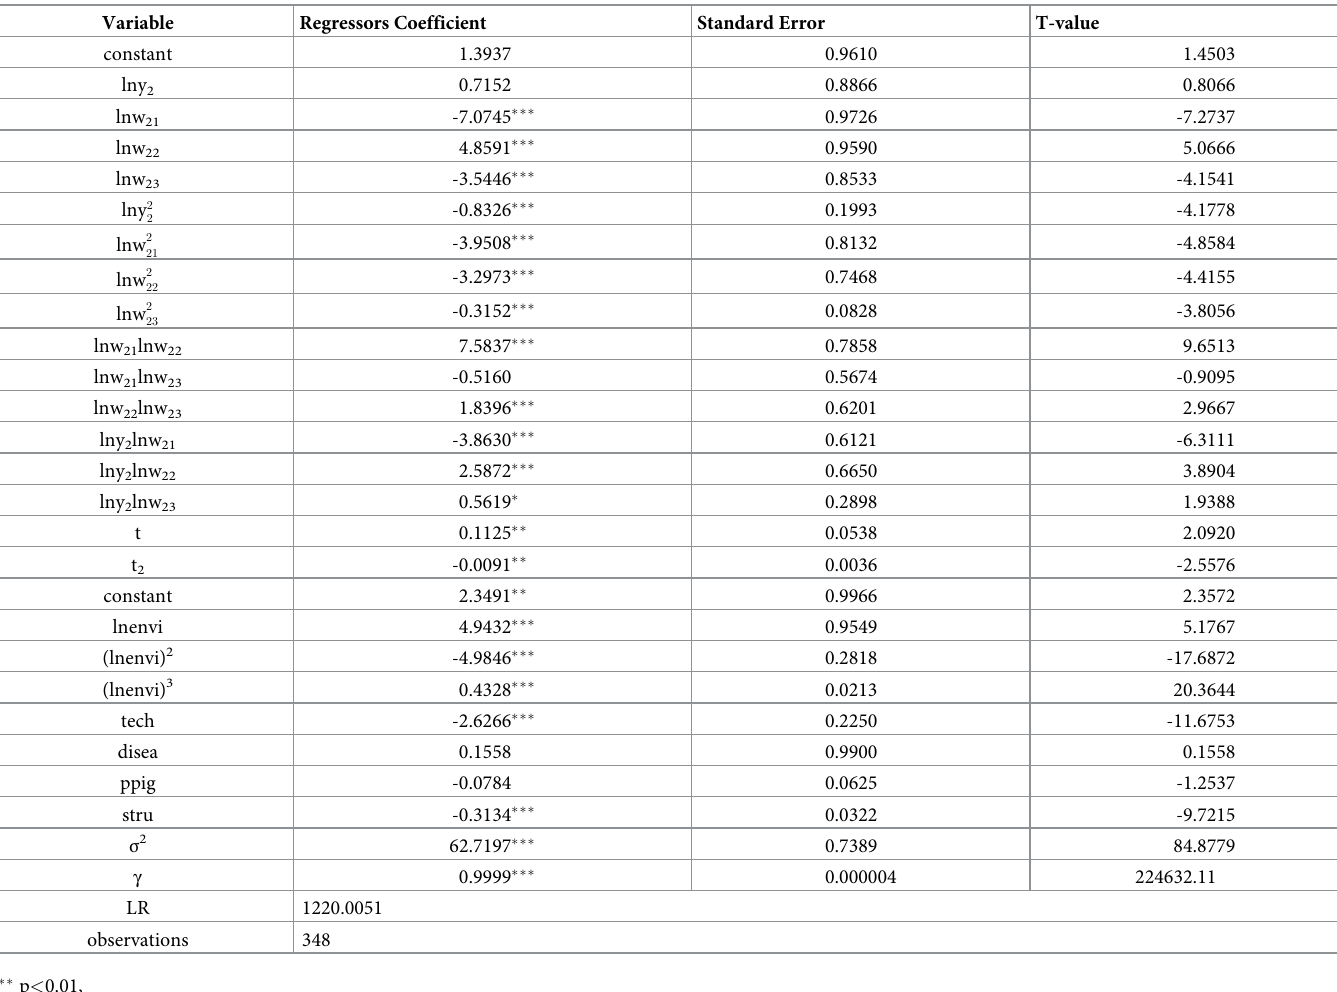
Table 5. Parameters of the translog stochastic cost frontier model for sows in